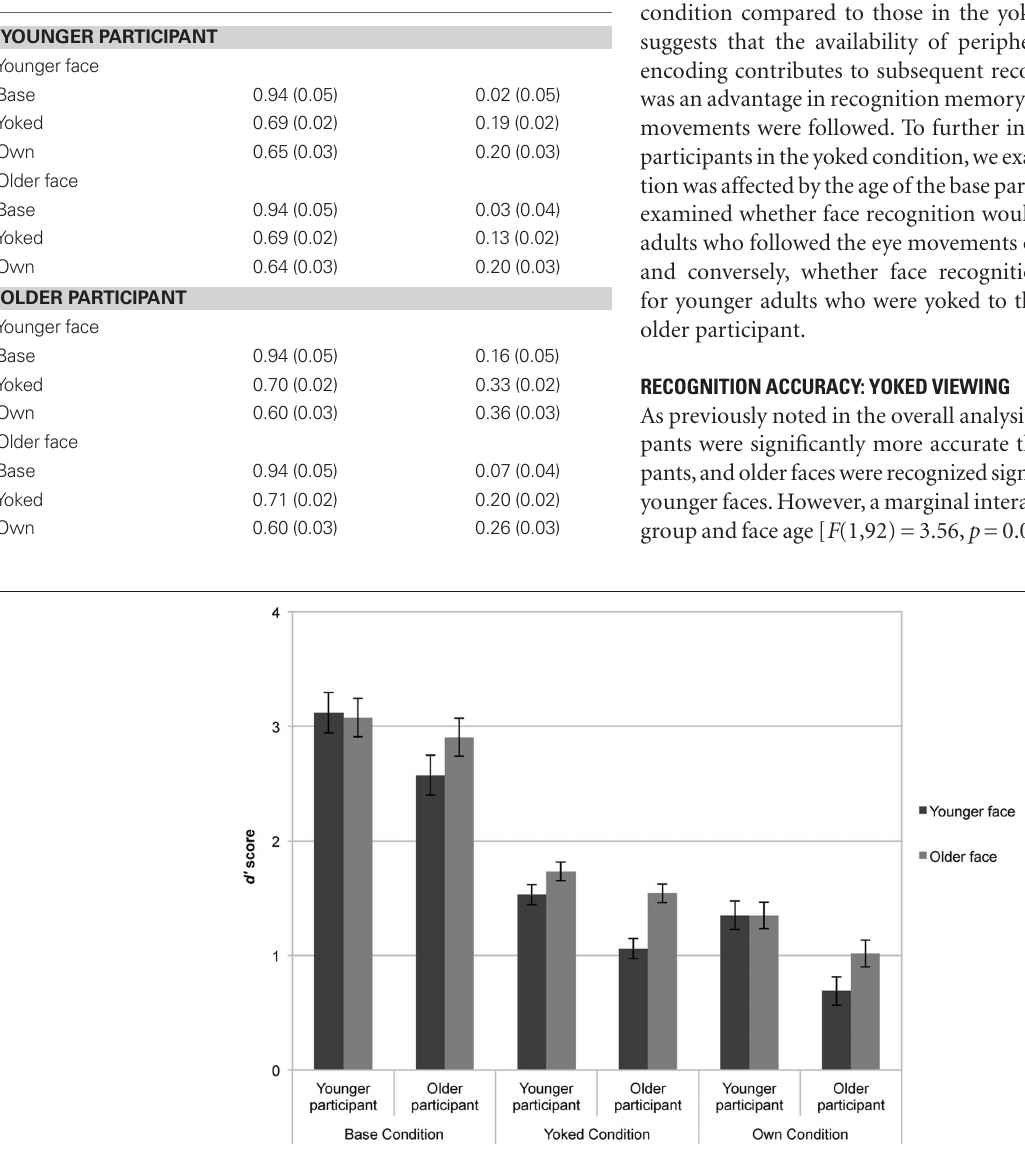
FiguRE 2 | Mean d ′ scores of younger and older faces for older and younger participants across the three viewing conditions (bases, yoked, own). Error bars represent standard error. Participants who freely viewed the faces during study were significantly more accurate than participants whose